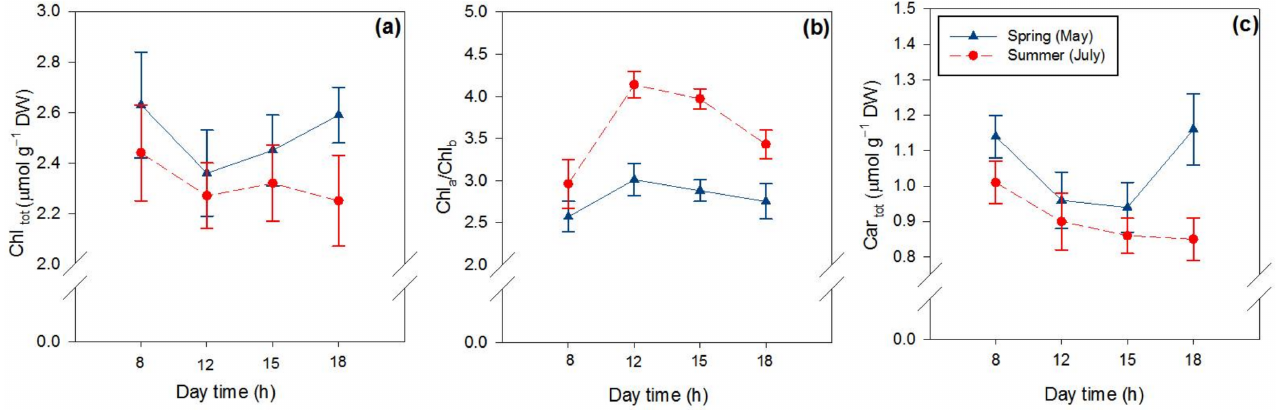
Figure 2. Seasonal and daily variations in total chlorophyll (Chl tot , ( a )), the ratio of Chl a to Chl b (Chl a /Chl b , ( b )) and total carotenoids (Car tot , ( c )) in the leaves of P. latifolia . Leaves were sampled at 08:00–09:00 (8 h in the graphs), 12:00–13:00 (12 h), 14:30–15:30 (15 h) and 17:30–18:30 (18 h) hours at two dates in spring (11–12 and 25–26 May, blue lines) and summer (4–5 and 22–23 July, red dashed lines) on clear days. Data are reported as means ± SD ( n =